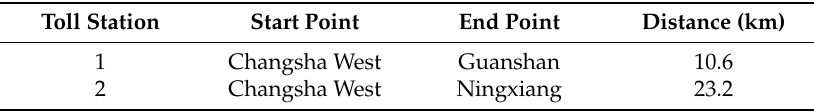
Table 2. Toll station for travel time